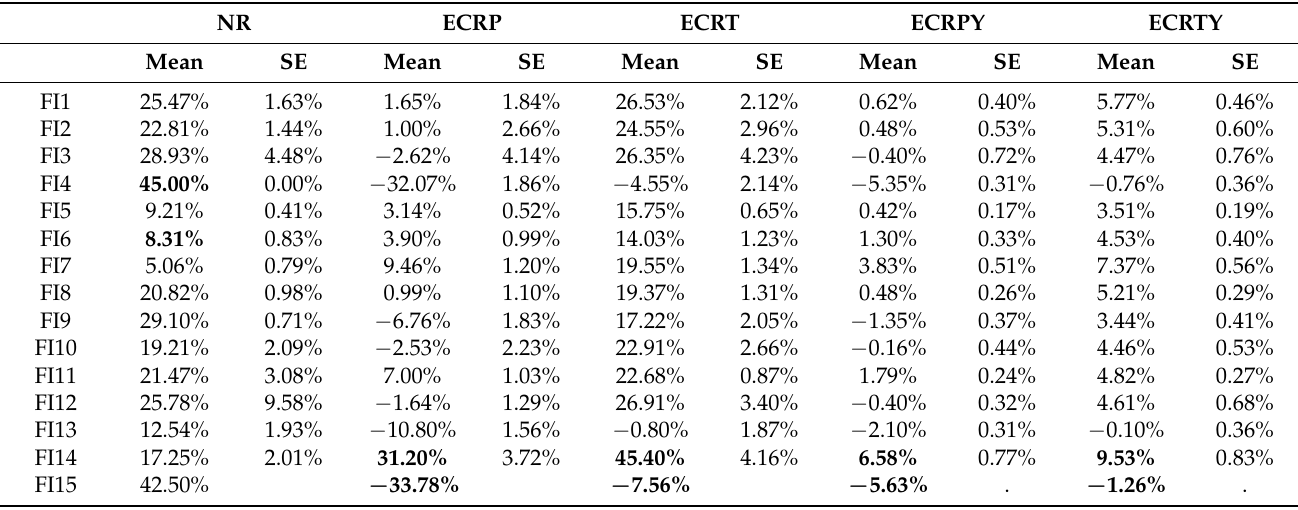
Table 6. The structured product return (NR) and the excess returns ( ECRP , ECRT , ECRPY , and ECRTY ) by issuer.